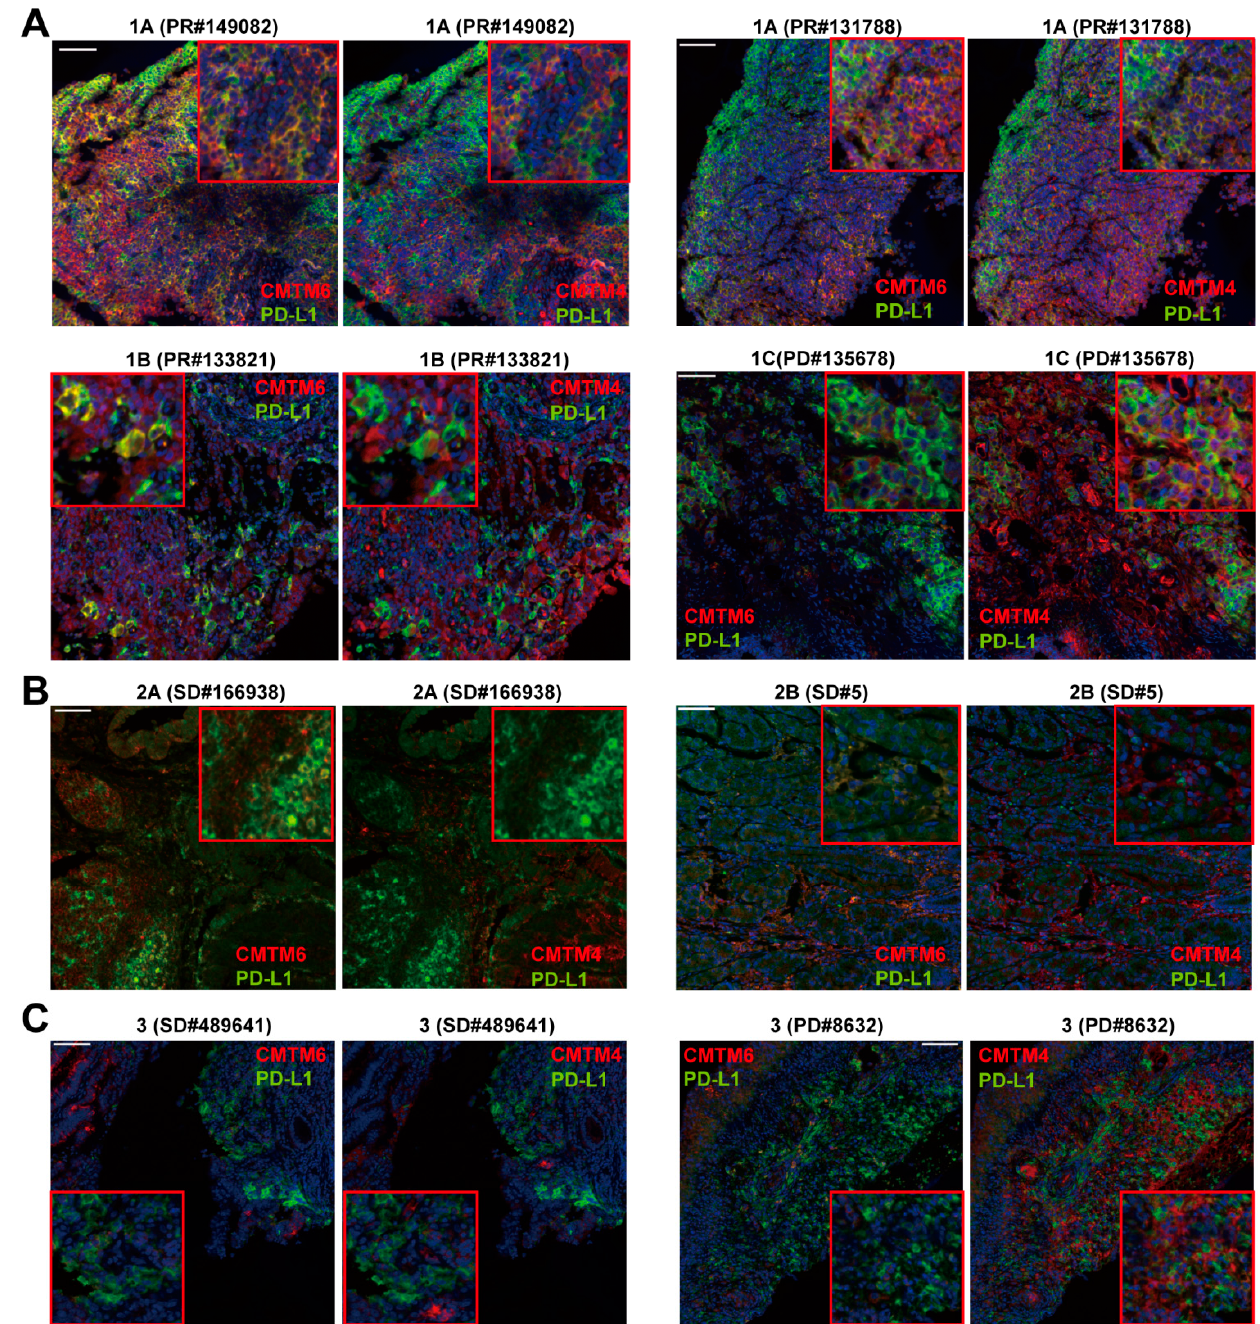
Figure 5. The pathological patterns of CMTMs and PD-L1 predict the efficacy of immunotherapy. ( A ) Pattern 1A was identified as CMTM6 + CMTM4 + PD-L1 + on the membrane of tumor epithelium, as shown in representative figures of case #149082. Pattern 1B showed the co-expression of CMTM6 and PD-L1 on the membrane of tumor epithelial cells without CMTM4 expression. Pattern 1C showed the co-expression of CMTM4 and PD-L1 on the membrane of tumor epithelial cells without CMTM6 expression. ( B ) Pattern 2A showed the co-expression of CMTMs with PD-L1 in the mesenchymal cells. Pattern 2B showed the co-expression of CMTM4 and CMTM6 without PD-L1 in the epithelial cells. ( C ) Pattern 3 showed single positive of CMTM6, CMTM4, and PD-L1 in different cells. Scale bar: 100 μ m. Pattern 2A had co-expression of CMTM6/4 and PD-L1 in the mesenchymal cells. More than half of the patients with pattern 2A were PD (2 PR, 2 SD, and 6 PD) (Figure 5B). The tumor epithelium with CMTM6 + CMTM4 + but PD-L1 - in the same cells was classified as pattern 2B. Unlike pattern 1, the intensity of CMTM6 and CMTM4 expression in pattern 2B was lower and was mainly found in the cytoplasm of tumor epithelial cells (Figure 5B,